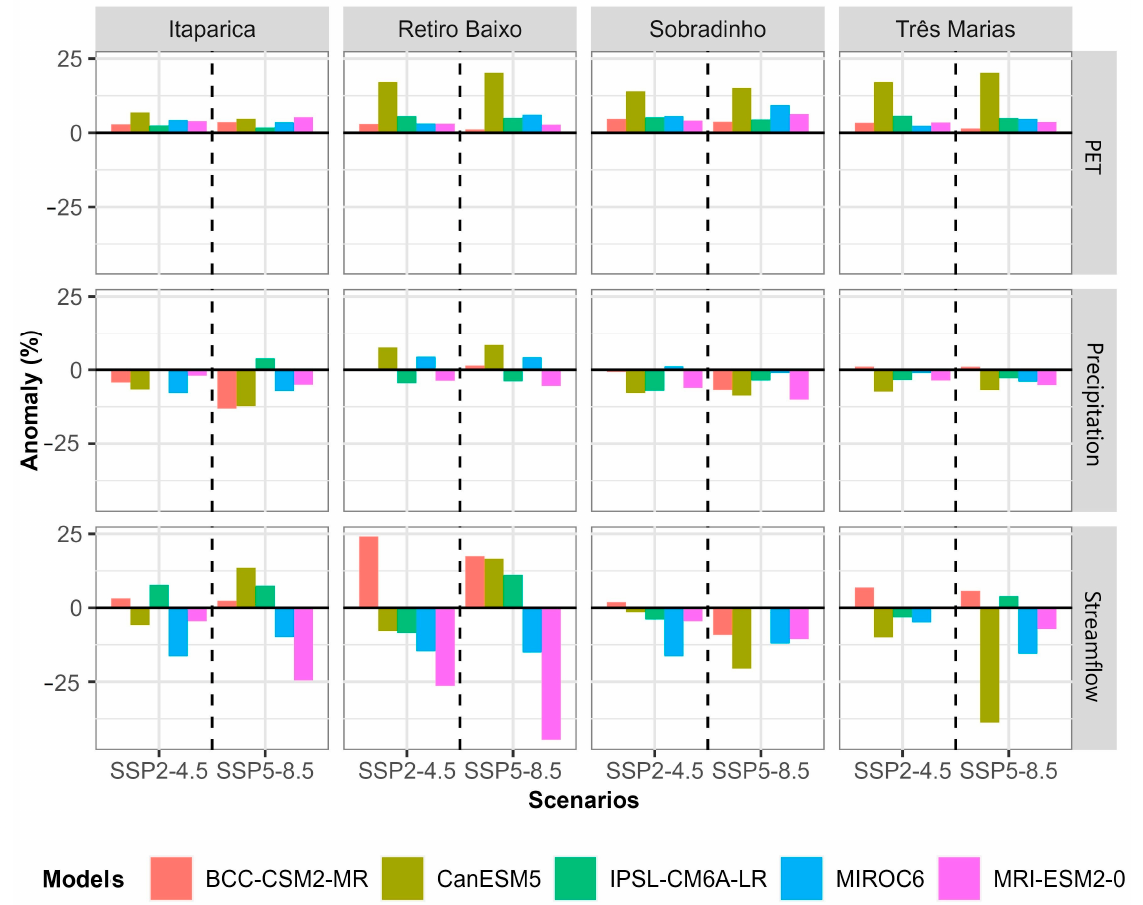
Figure 7. Percentual Anomalies of the PET, Precipitation and Mean Annual Streamflow from CMIP6 models.